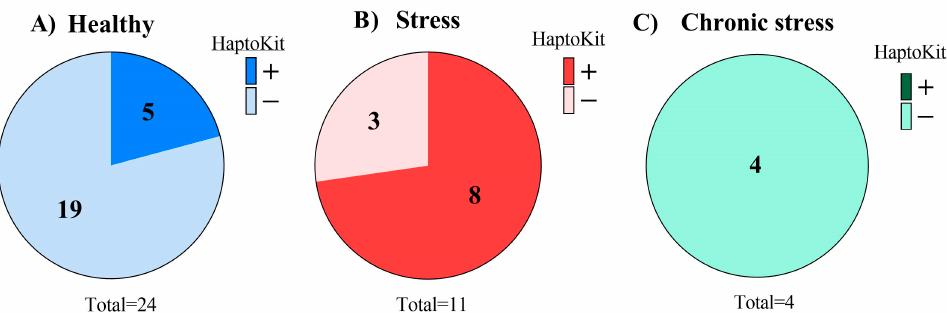
Figure 2. Results of the Haptokit analysis on different milk samples. ( A – C ) Pie charts of the Haptokit results. The 39 animals were distributed into three groups, one with healthy animals ( A ), one with acutely stressed animals ( B ), and one with animals suffering from chronic stress ( C ).